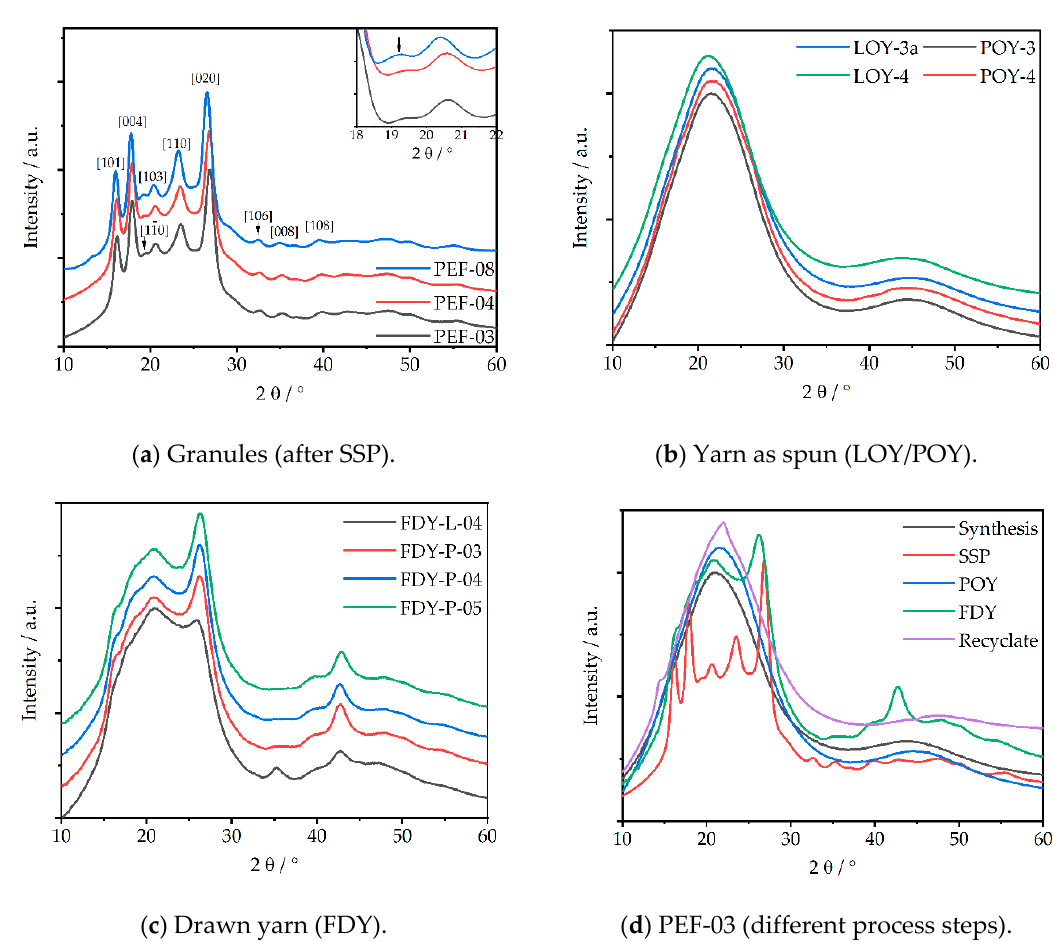
Figure 3. X-ray diffraction pattern of PEF yarn at different process steps. ( a ) Granules (after SSP); ( b ) yarn as spun (LOY/POY); ( c ) drawn yarn (FDY), and ( d ) PEF-03 (different process steps).